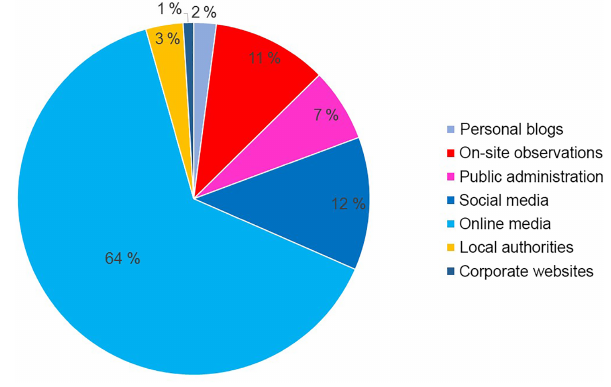
Figure 1. Distribution of data sources in the DamaGIS database for the 2011–2016 period. New media are represented in shades of